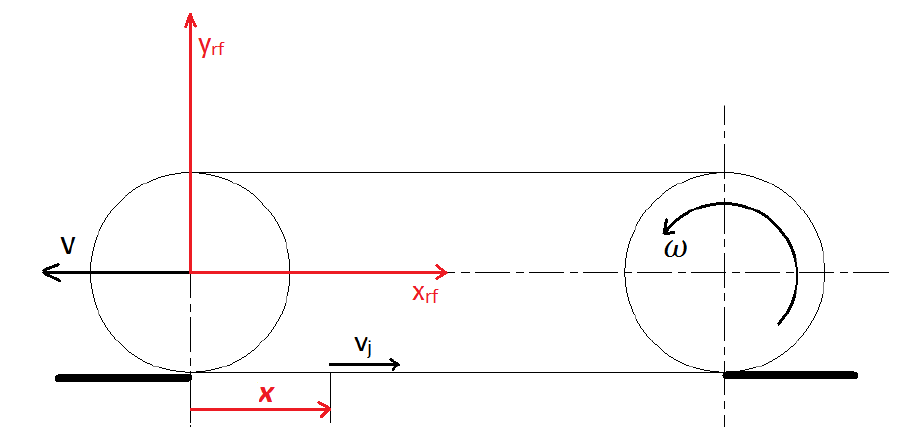
Figure 11. Coordinate system for traction force equation